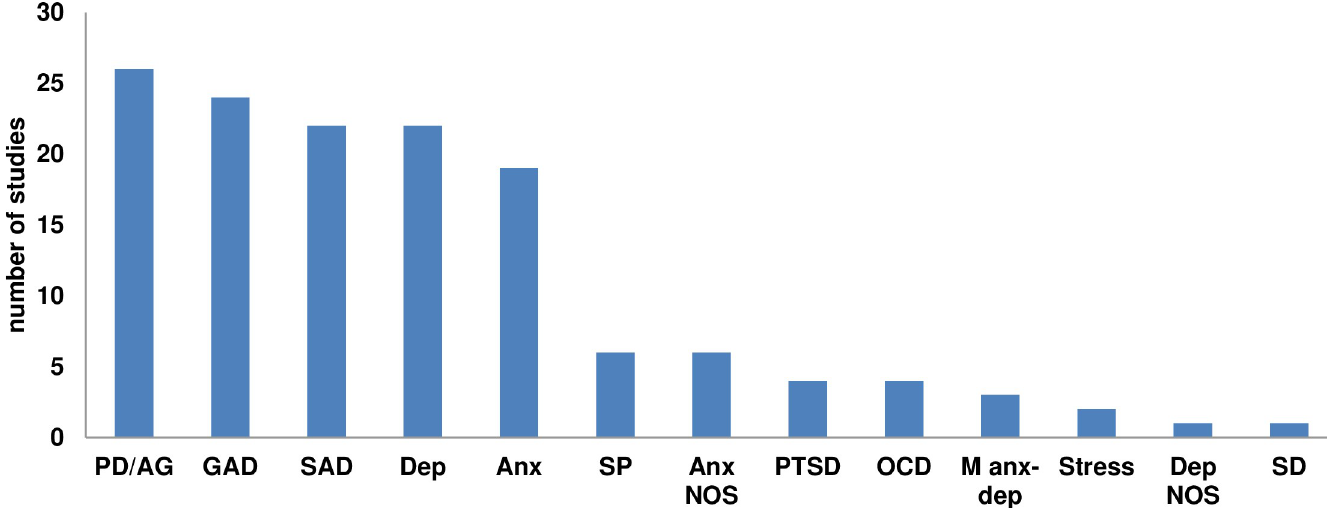
Fig 3. Number of studies that target the different diagnoses. Note . PD/AG: Panic disorder/agoraphobia; GAD: Generalized anxiety disorder; SAD: Social anxiety disorder; Dep: Depression; Anx: Anxiety; SP: Specific phobia; Anx NOS: Anxiety not otherwise specified; PTSD: Posttraumatic stress disorder; OCD: Obsessive- compulsive disorder; M anx-dep: mixed anxiety and depression disorder; Dep NOS: Depression not otherwise specified; SD: somatoform disorder.